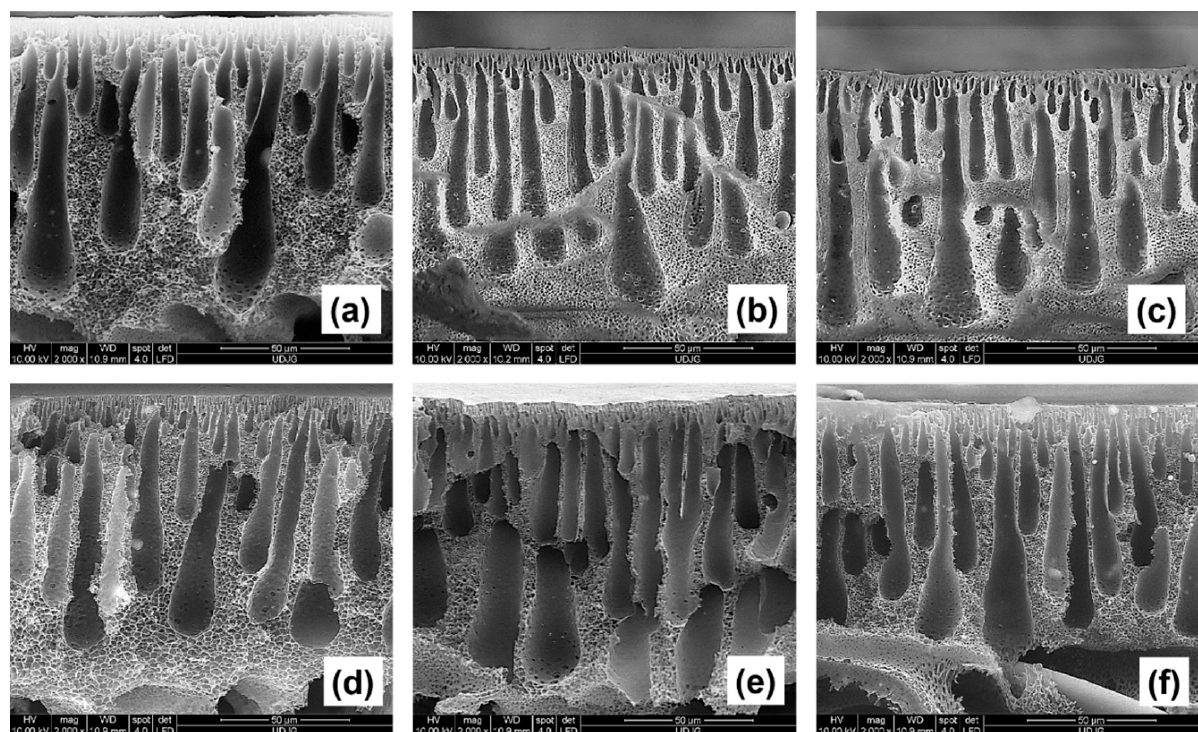
Figure 3. Cross-section SEM images of nanocomposite membranes modified by the addition of titanium dioxide nanopar- ticles. Each membrane contains a different concentration, rutile: 0.1 wt.% ( a ), 0.5 wt.% ( b ) and 1 wt.% ( c ); and anatase: 0.1 wt.% ( d ), 0.5 wt.% ( e ) and 1 wt.% ( f ).